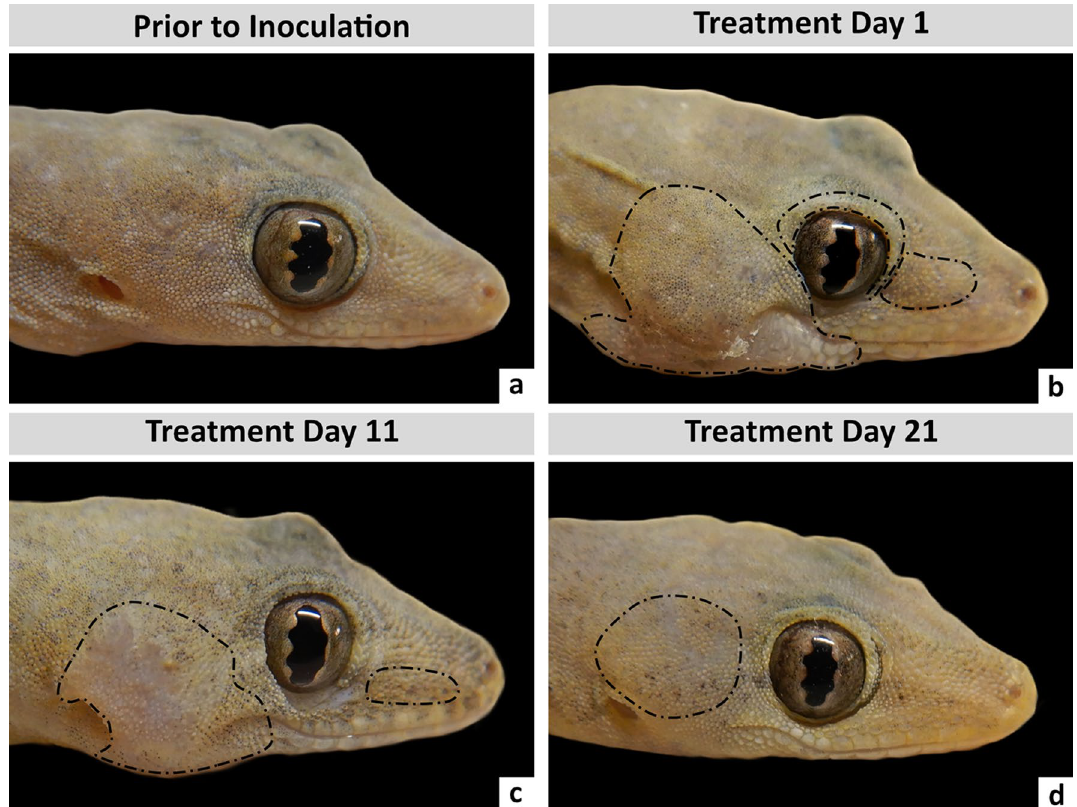
Figure 4. Treatment timeline of an Asian house gecko (gecko ID: SkL-4) experimentally infected with E. lacertideformus where lesions are delimited with a broken black line to illustrate the near complete regression of gross disease following treatment with enrofloxacin . Gecko prior to experimental inoculation via skin laceration at the right cheek ( a ). Representative lesions of E. lacertideformus observed at one ( b ), eleven ( c ), and 21 days ( d ) of oral antibiotic treatment with enrofloxacin. Near complete regression of gross lesions during antibiotic treatment is apparent, with markedly reduced subcutaneous swelling of the right cheek caudal to the eyes and cranial to the ear canal ostium ( b – d